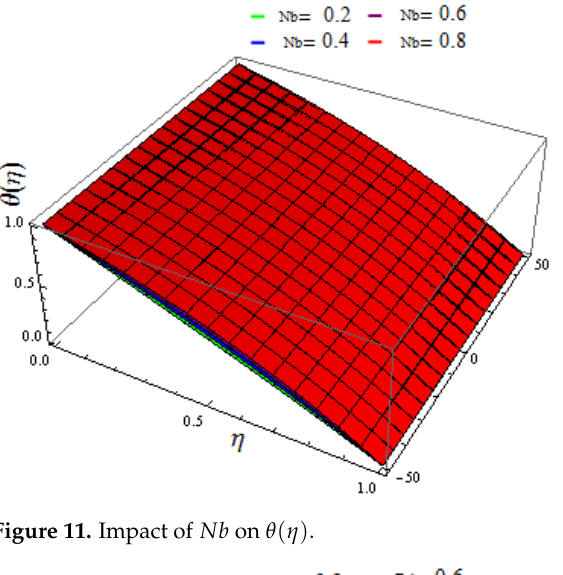
Figure 11. Impact of 𝑁𝑏 on 𝜃(𝜂) .